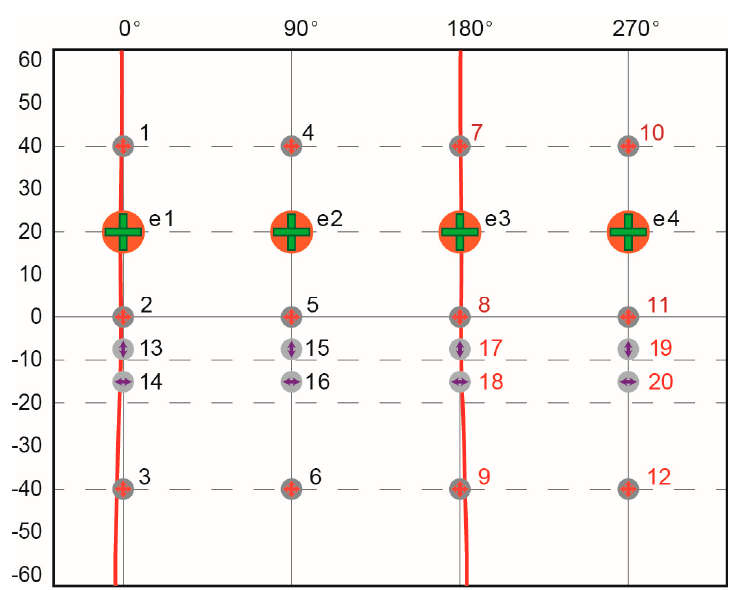
Figure 2. The configuration of PZTs and strain gauges mounted on the sample surface. The strain gauges are labeled e1–e4 and the horizontal and vertical strain can be measured for each strain gauge. The P-and S-wave sensors are labeled 1–12 (orange “+” symbols) and 13–20 (purple arrows), respectively. The red line indicates the pre-existing fracture generated during drying.